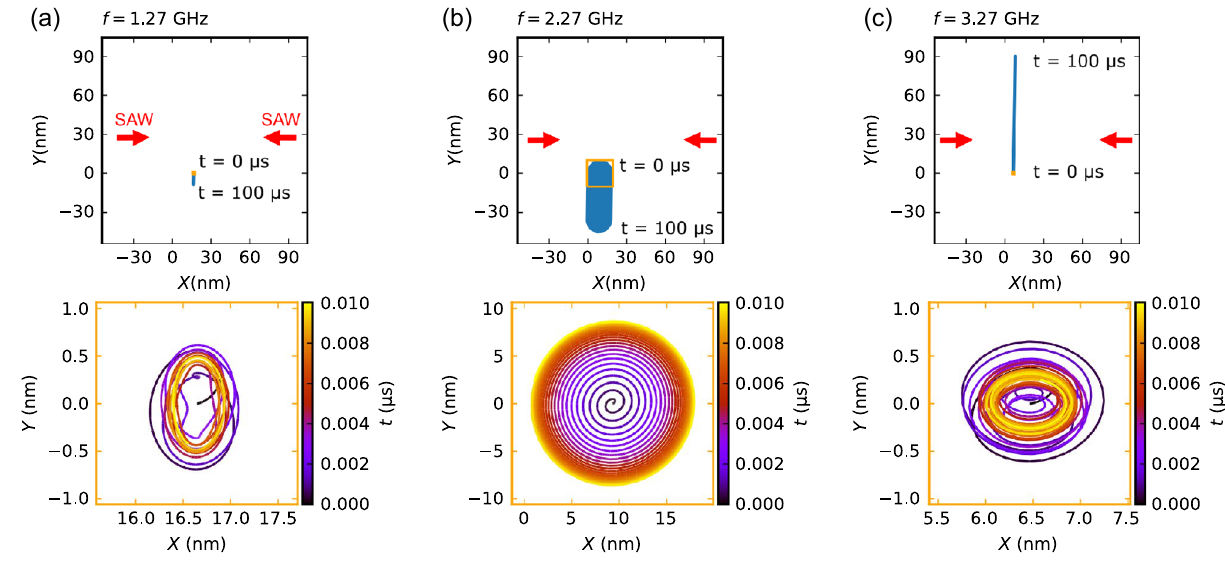
Figure 1. Trajectory of skyrmion in the presence of standing SAWs applied only in the x -direction. Results are 1.27 GHz; ( b ) 2.27 GHz (resonant frequency); and ( c ) 3.27 GHz. The shown at three SAW frequencies: ( a ) f x = 100 µ s ), and the bottom panels t top panels show the results obtained from the long-time simulation ( 0 ≤ ≤ 0.01 µ s ) marked by the yellow square in the top panels. The t are magnified views of short time region ( 0 ≤ ≤ change in the colors of data indicates the time evolution of skyrmion position. Skyrmons are initially placed ( 0.01 (cid:31) , 0 ) to break the symmetry, where (cid:31) v / f is the wavelength of the SAW. We take the node of at R ( 0 ) = = 0 0 ( (cid:31)(cid:30) SAWs at x x = =